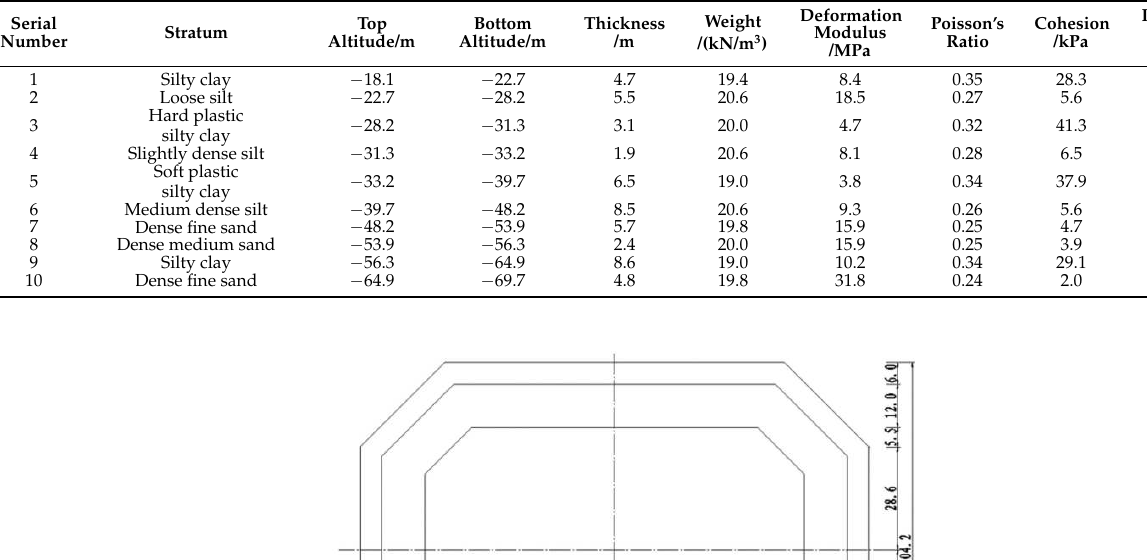
Table 1. Stratum and soil parameters.